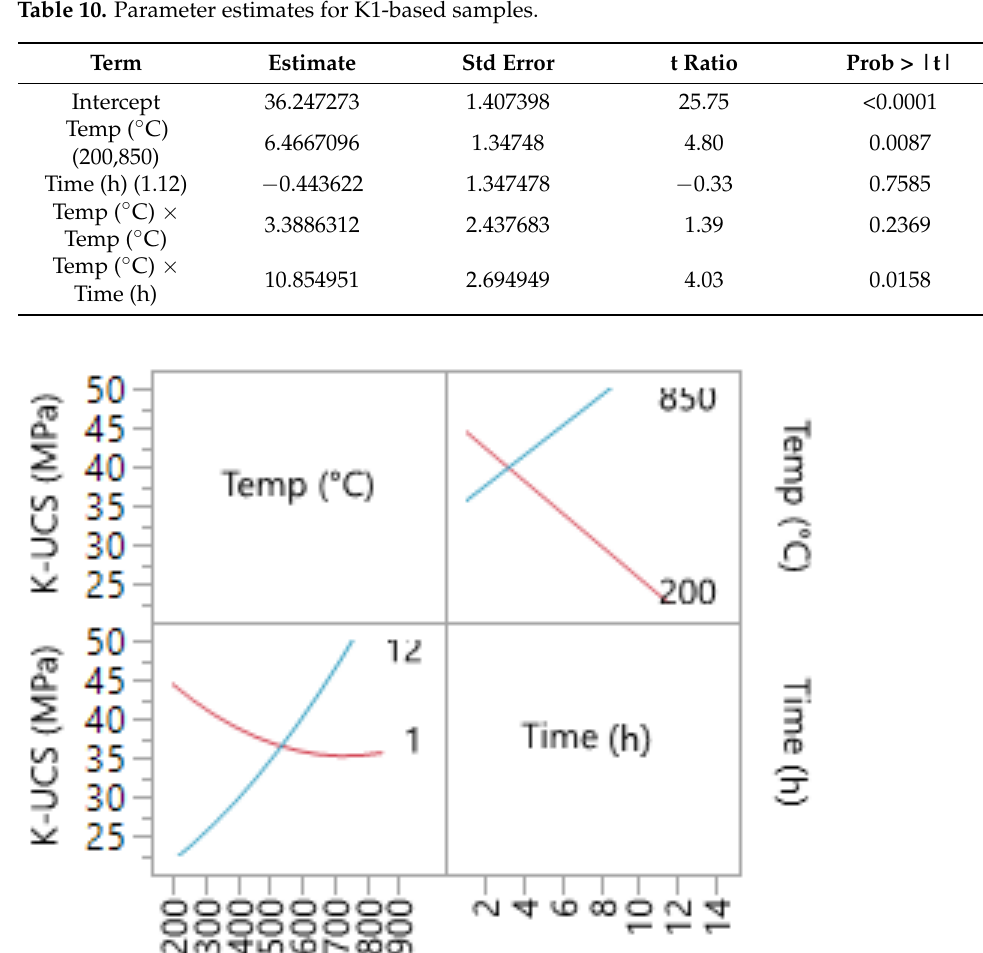
Figure 9. Interaction profile for time and temperature for K1-based samples.